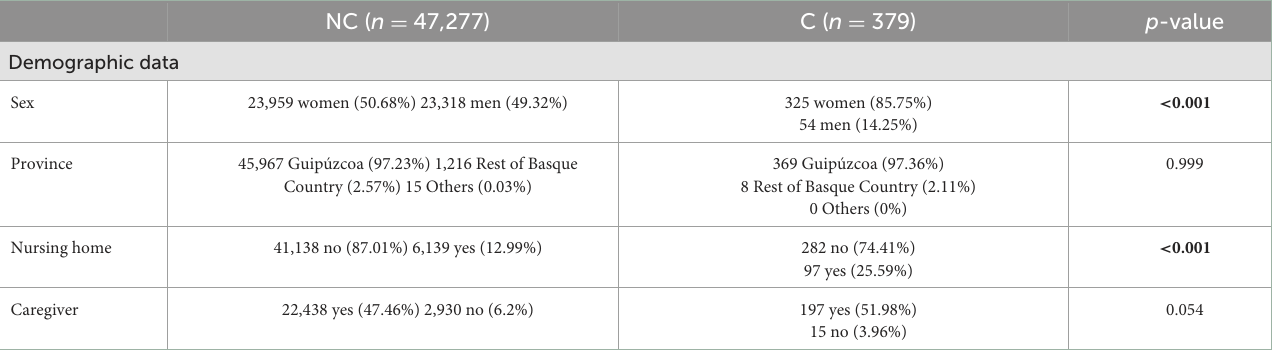
TABLE 1 Demographic features of centenarians and non-centenarians. Number of individuals and percentages (%).